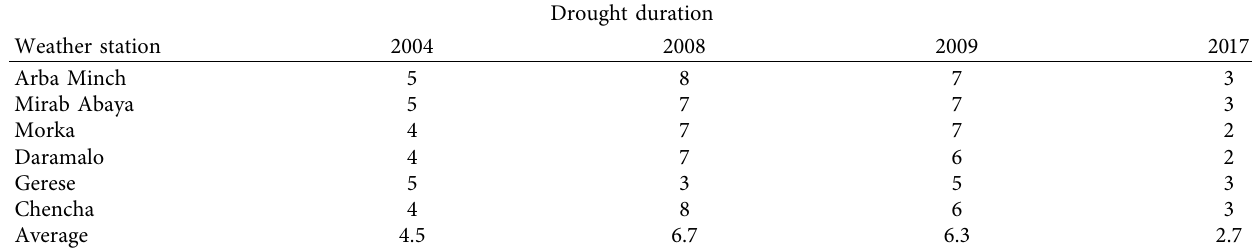
Table 7: Average drought duration in months for the Gamo Zone.